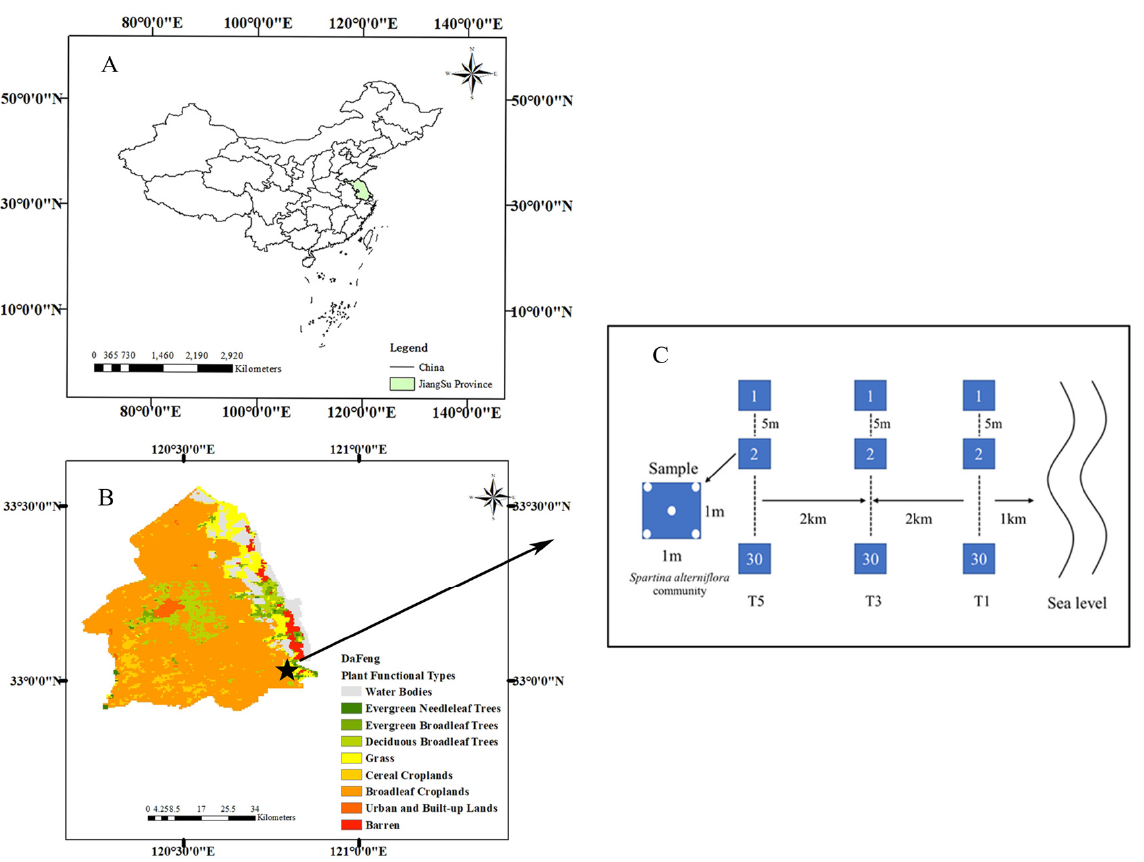
Figure 1. Location of Dafeng Elk Nature Reserve in Jiangsu, China ( A ), the classifications from the MODIS Land Cover Type Product (MCD12Q1) ( B ), and the sampling design used in the present study ( C ). T1, T3, and T5 represent three tidal levels, 1, 3, and 5 km from the coastline, respectively. Samples were collected from 1 m × 1 m plots at 30 points along each sample line.